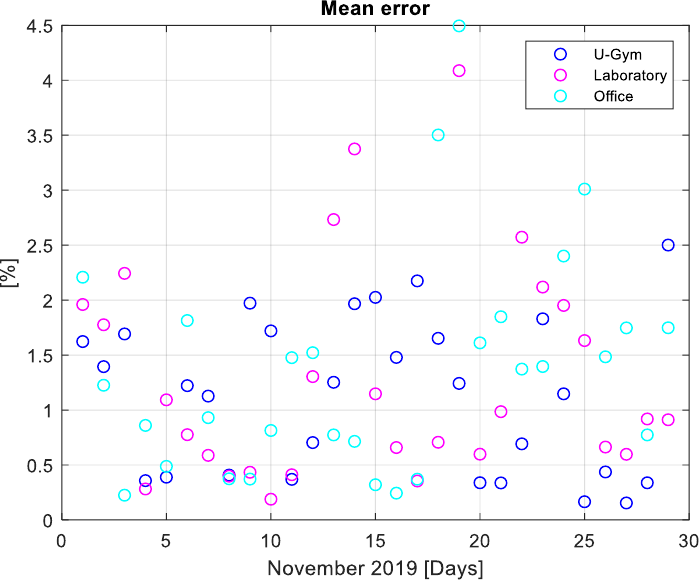
Figure 8. Nighttime temperature mean percentage error.